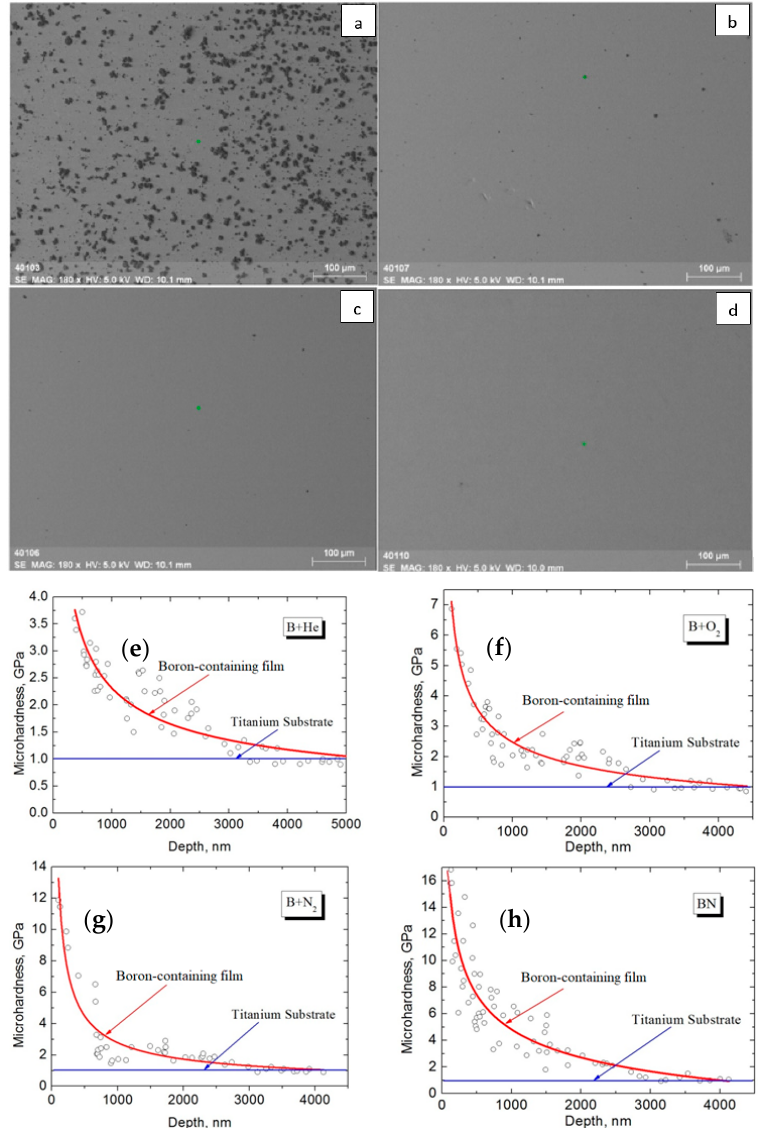
Figure 30. Photographs of boron-based coatings at different electron-beam power densities: ( a ) 30 kW/cm 2 ; ( b ) 25 kW/cm 2 ; ( c ) 20 kW/cm 2 ; ( d ) 15 kW/cm 2 . Graphs [139] represent a micro-hardness of boron-containing coatings vs. depth during evaporation of boron in helium ( e ), oxygen ( f ), nitrogen ( g ), and of boron nitride in the residual atmosphere ( h ).